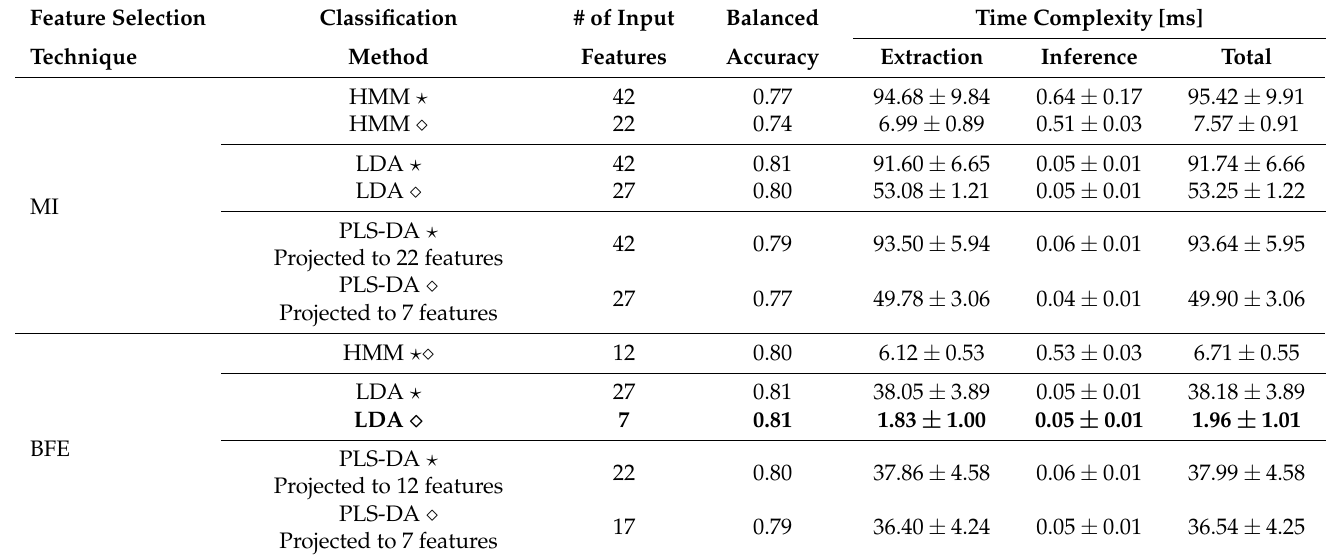
Table 1. Comparison of model performance and time complexity for MI and BFE feature selection approaches for HMM, LDA and PLS-DA classification algorithms. The (cid:63) models achieve maximum balanced accuracy performance, while the (cid:5) models are those that are manually selected and balance the trade-off between balanced accuracy and time